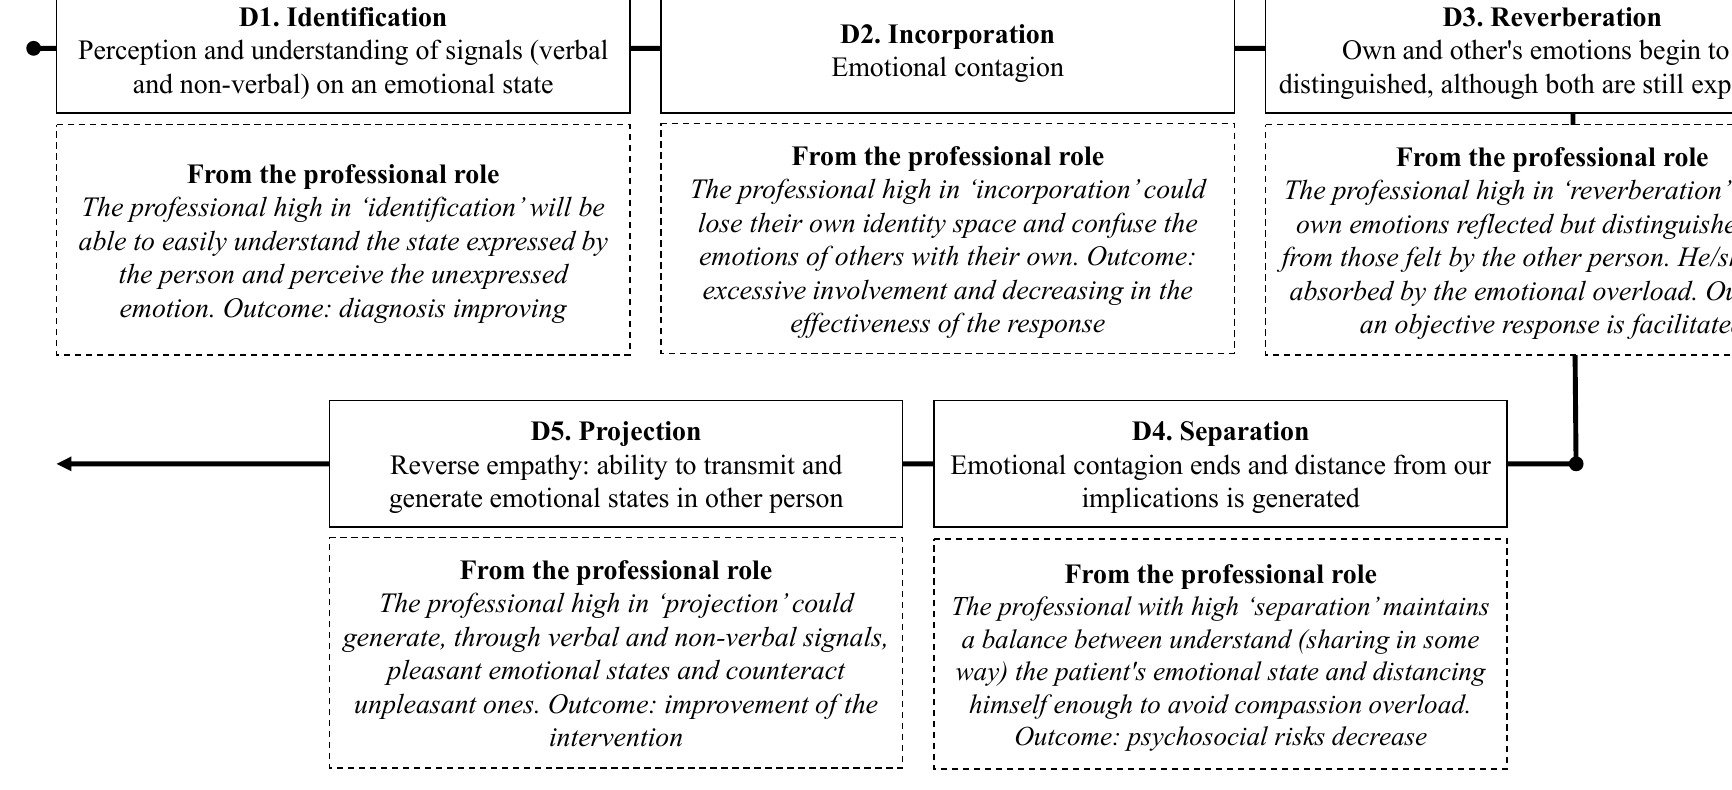
Figure 1. Sequence of the empathy process according to the EMS (adapted from Reik) and application to professionals.